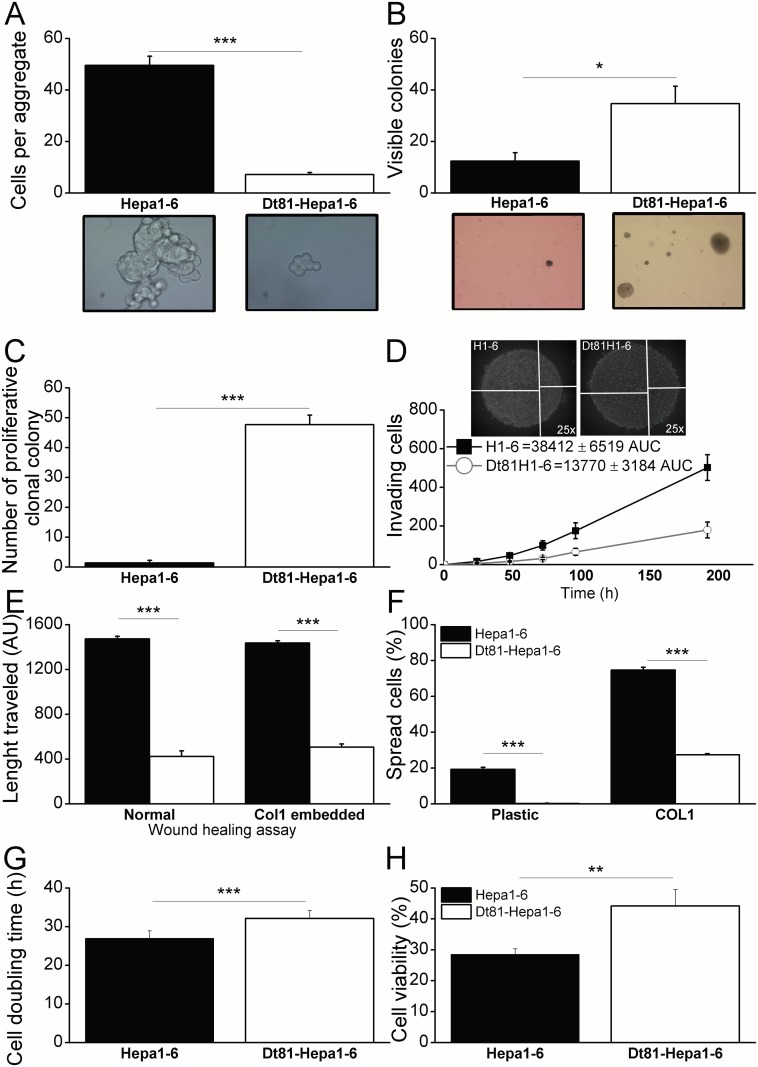
Dt81Hepa1-6 in vitro neoplastic profile.A cell aggregation assay was performed and (A) the number of cells per aggregate was calculated 24h after seeding both cell lines in non-adherent agar-coated wells. Representative microphotographs are shown. In order to evaluate anchorage-independent growth, a soft-agar colony formation assay was performed; (B) cell lines were seeded at 10K-cell concentration in soft-agar gel [0.3%] in order to form visible colonies and were counted 5 weeks later. Representative microphotographs of cells after 5 weeks are shown. The ability of independent cells to form colonies without cell-to-cell contact was assessed by a proliferative clonal colony assay; (C) cell lines were seeded at 3K/mL concentration to obtain isolated cells and left to grow as colonies over a 4 weeks period and counted. The potential for invasiveness was evaluated with a double-layer droplet cell invasion assay; (D) Cell lines [20K cells] were embedded in COL1 [3mg/mL] to form a double layered droplet and cells penetrating the outer COL1 layer were counted every 12h for 8 days. Area under the curves (AUC) of the time-dependent invasion was calculated and used for statistical analysis. Representative microphotographs are shown. For the wound-healing assays (WHA); (E) normal and COL1-embedded WHA were performed on confluent cells for 24h and length traveled was evaluated using ImageJ. For the cell-spreading assay, (F) Cell lines were seeded for 6h on plastic and COL1 and cells showing an elongated morphology were counted manually. (G) Cell doubling time for Dt81Hepa1-6 and parental Hepa1-6 cells. (H) Viability of Dt81Hepa1-6 and Hepa1-6 cells following in vitro exposure to cisplatin [25ug/mL] for 24h. (*P<0.05; **P<0.01; ***P<0.001).